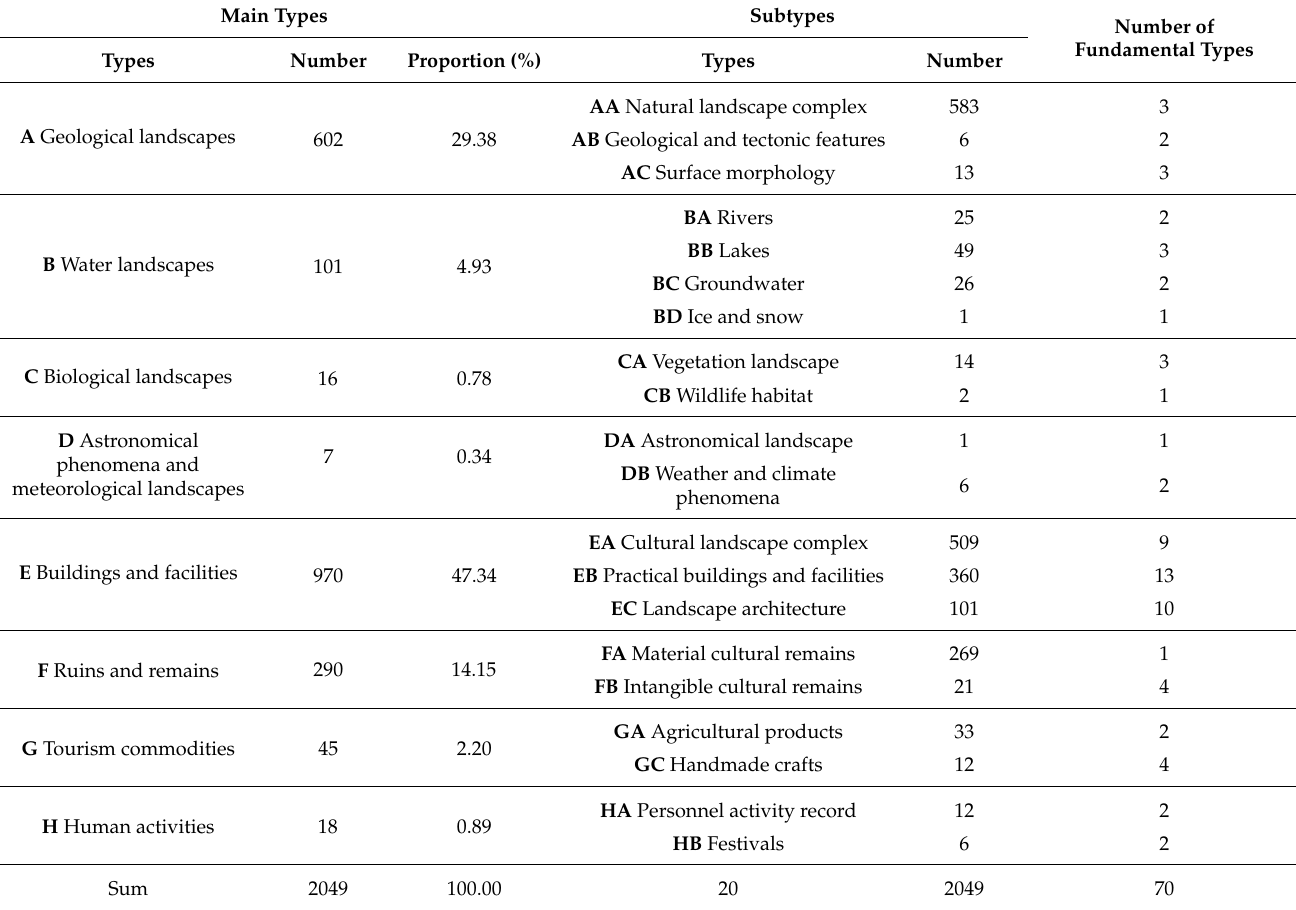
Table 1. Quantity and basic types of tourism resources in Longde